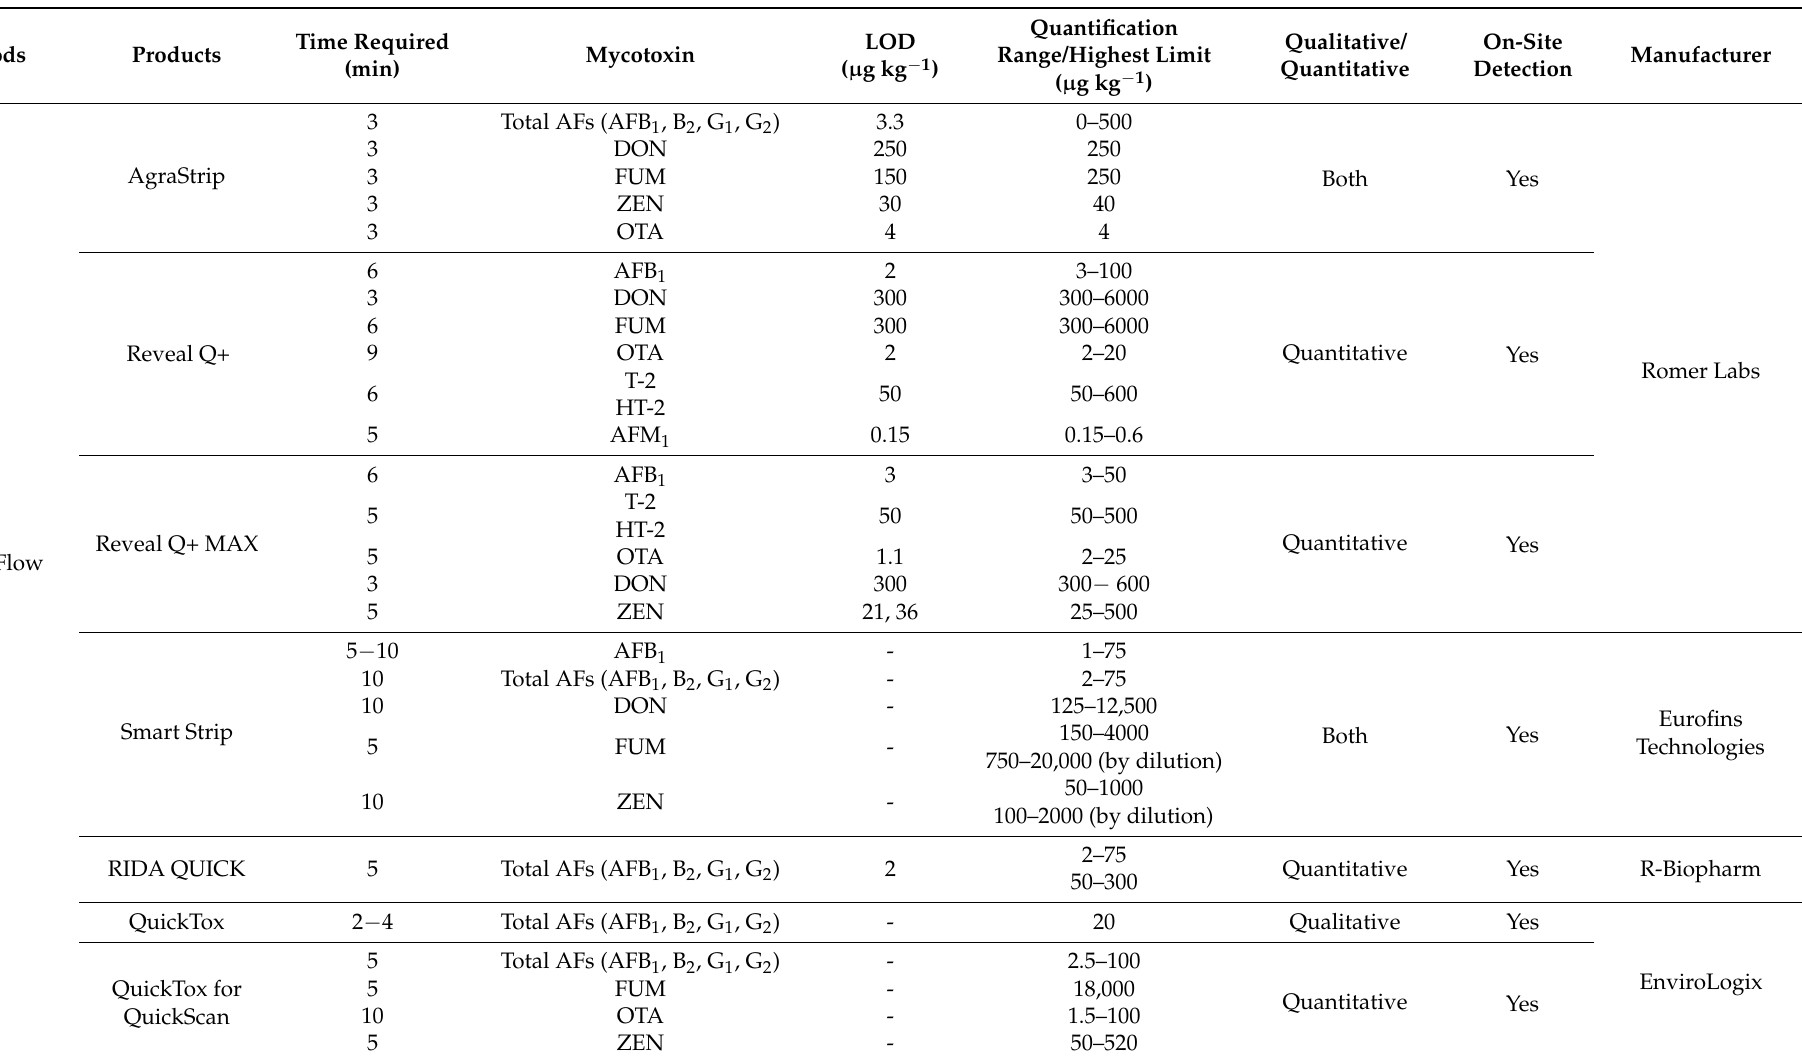
Table 6. Summary of various commercially available mycotoxin detection